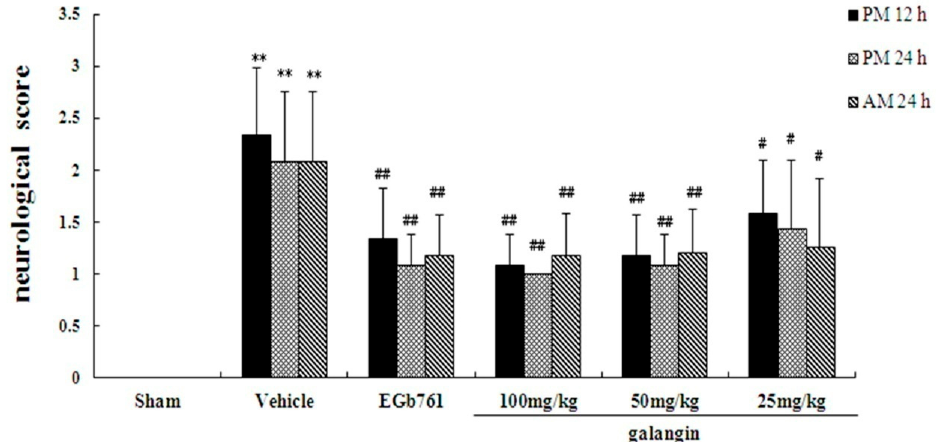
Figure 2. Effect of galangin on neurological deficits induced by MCAO and the neurological examination scores (behaviour test). In the neurological examination, a higher score indicates a worse pathological condition. The score of each experimental group is the average of ten subjects ′ behavioural performances. The values are expressed as the means ± SD ( n = 10), and the data were analysed using one-way ANOVA; ** p < 0.01 versus the sham groups, ## p < 0.01, # p < 0.05 vs. the vehicle groups.